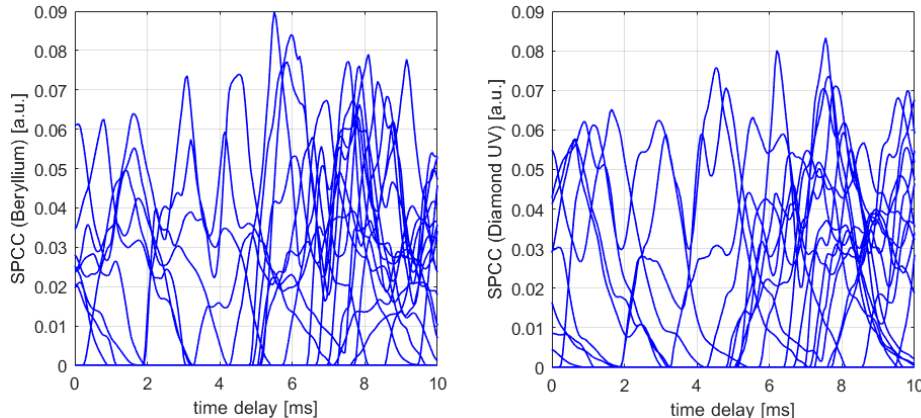
Figure 9. SPCC profiles ( left using beryllium line, right using diamond UV) of the detected ELMs of shot 92237 correlated with the pellet of shot 92238.